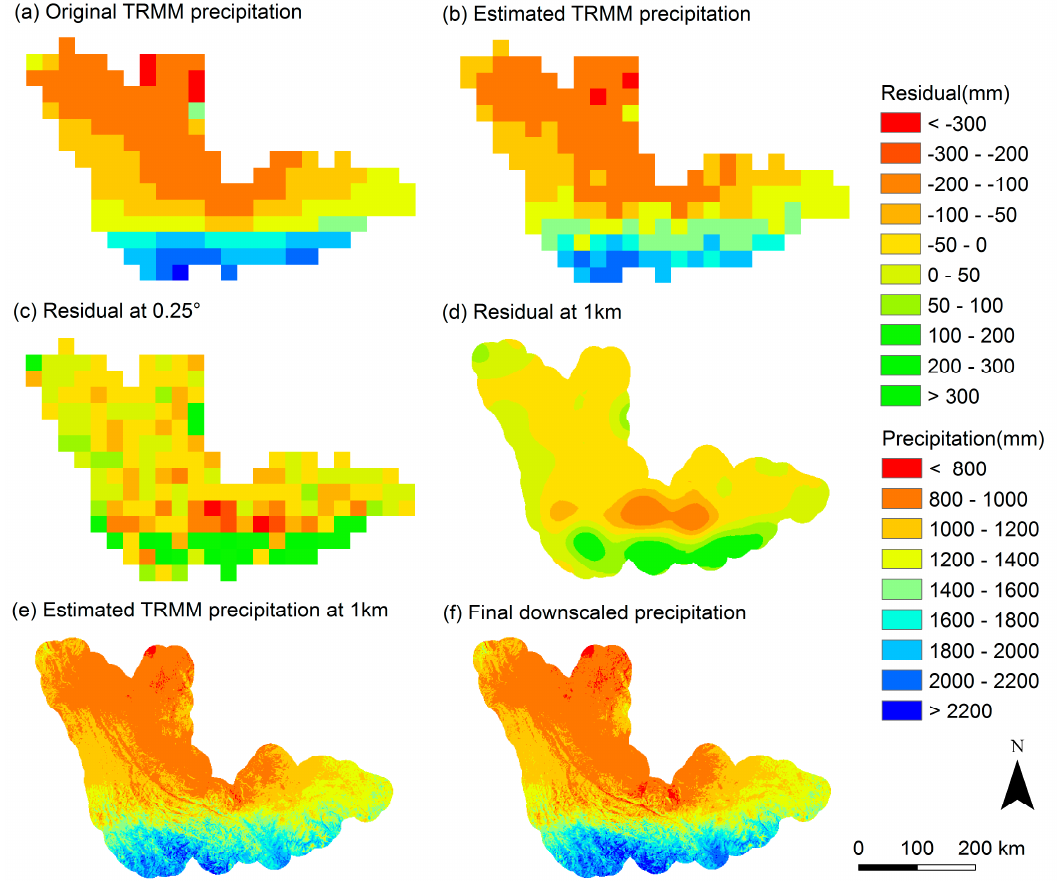
Figure 7. Downscaled results of annual average TRMM precipitation covering a period of 2001–2015: ( a ) the original TRMM 3B43 precipitation at 0.25° resolution; ( b ) the estimated TRMM 3B43 precipitation at 0.25° resolution by GWR; ( c ) residual at 0.25° resolution; ( d ) residual at 1-km resolution; ( e ) the estimated TRMM 3B43 precipitation at 1-km resolution; and ( f ) the final downscaled precipitation map.